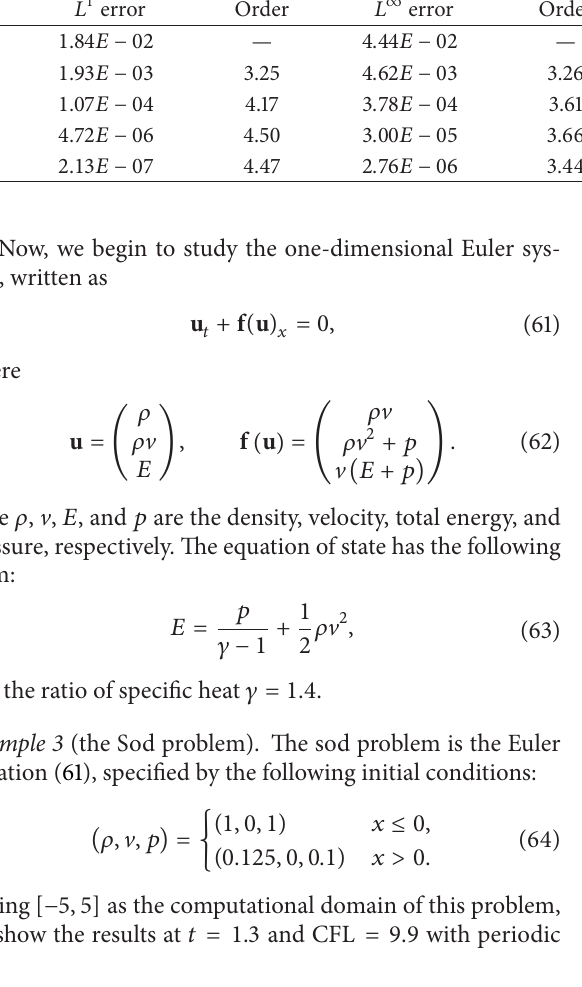
Table 3: Left: FV WENO 5 scheme, right: FD WENO 5 scheme for Example 1 on a uniform mesh of 𝑁 cells at 𝑡 = 0.5 , CFL = 0.2, and 𝜀 = 10 −6 . 𝑁 FV WENO 5 FD WENO 5 𝐿 1